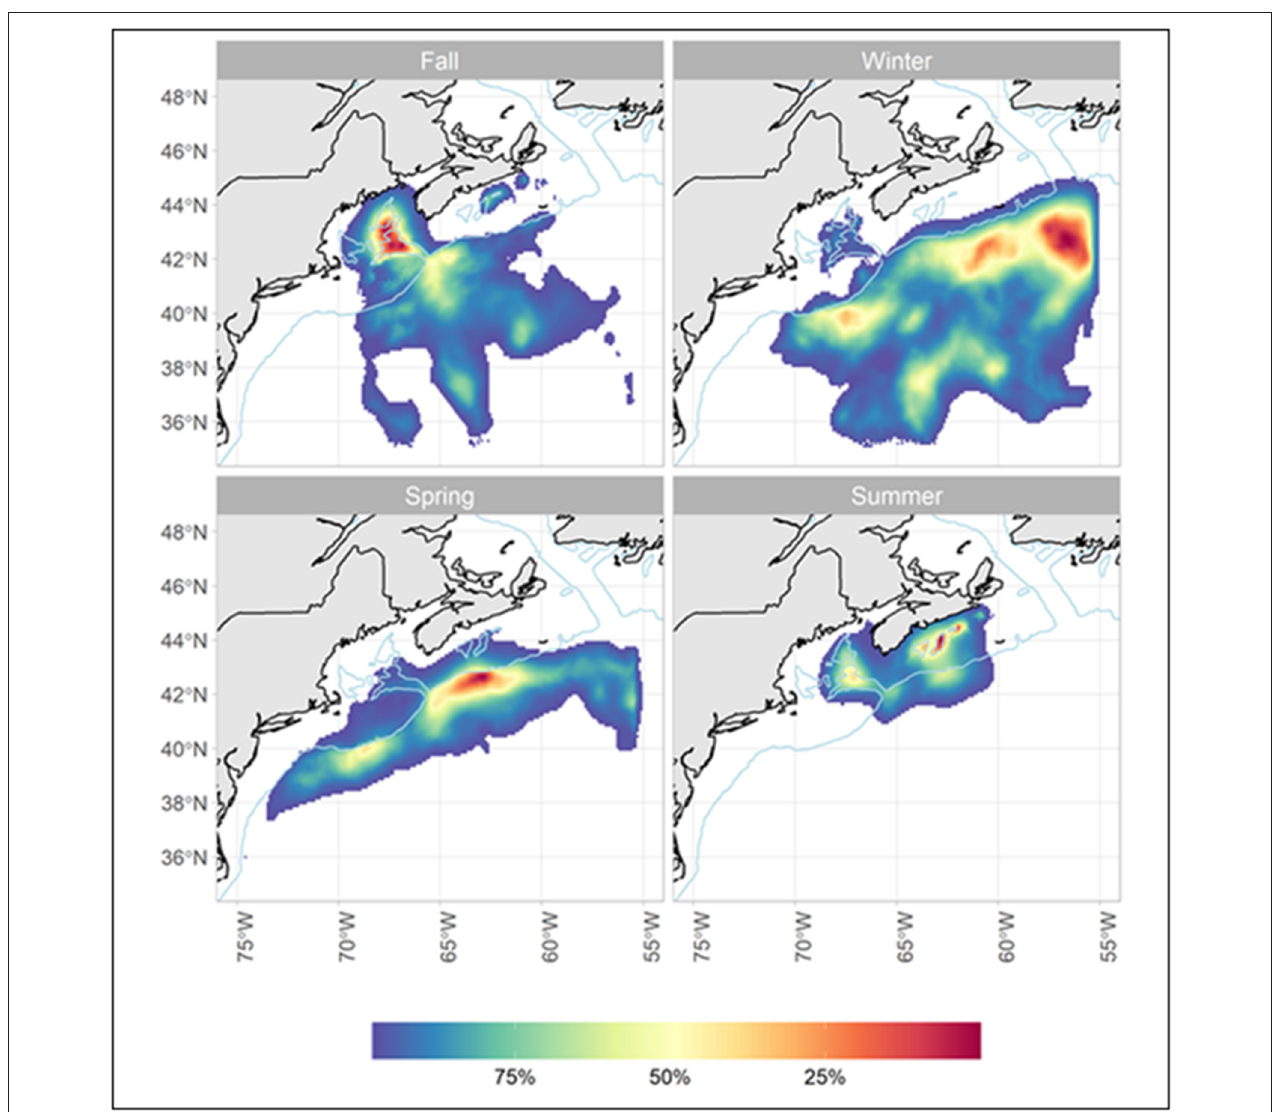
FIGURE 2 | Residency density plots showing seasonal distribution of juvenile porbeagles tagged in the western North Atlantic; seasons are based on the lunar calendar (mo/d: Fall, 9/20–12/19; Winter, 12/20–3/19; Spring, 3/20–6/19; Summer,